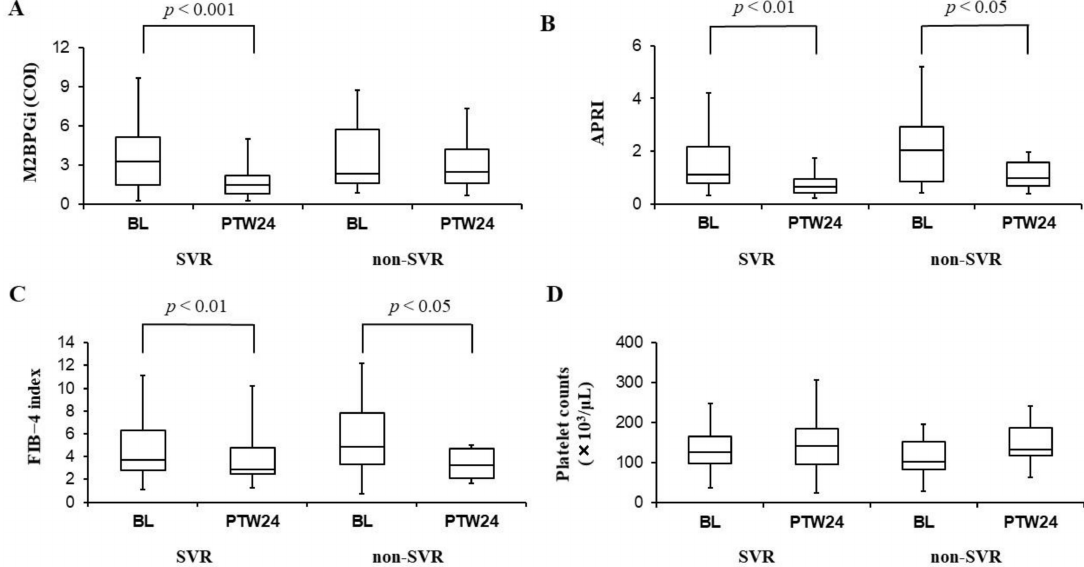
Figure 1. Serum mac-2 binding protein glycosylation isomer (M2BPGi) levels ( A ), aspartate aminotransferase to platelet ratio index (APRI) ( B ), fibrosis-4 (FIB-4) index ( C ), and platelet counts ( D ) before (BL: Baseline) and 24 weeks after the